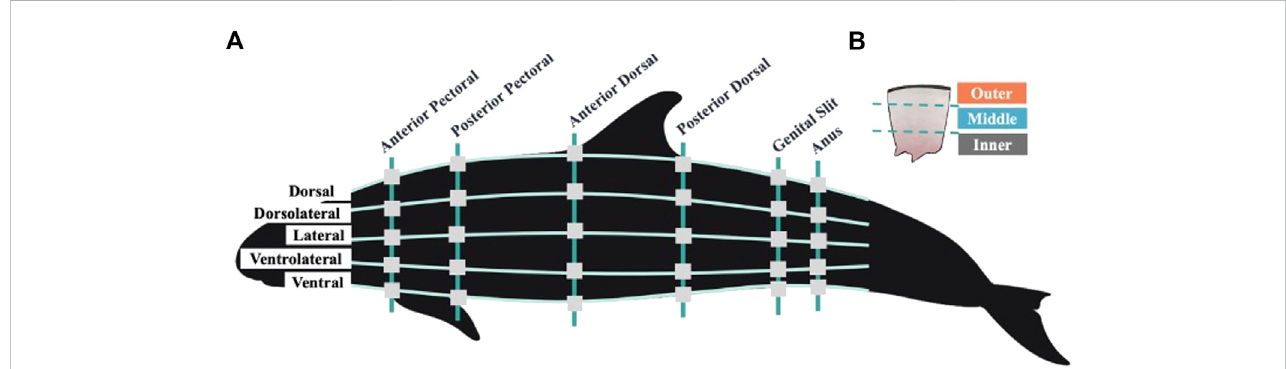
FIGURE 1 (A) Visualrepresentationofblubbersamplinglocationsacrosstheleftsideofthefalsekillerwhalebody.Verticallinesrepresentsixanatomicallyidenti fi ed girth axes, horizontal lines represent fi ve equidistant sampling planes. Square gray boxes show the locations at which blubber was sampled during necropsy. While not illustrated here, the dorsolateral, lateral, and ventrolateral sampling planes were mirrored on the right side of the animal ’ s body at all girth axes resulting in a total of 48 sampled locations across the body topography. (B) Illustration of a single blubber sample and the three blubber layers. Illustrations created by Conner Humann and Jana Phipps using Procreate digital illustration app and Photoshop.